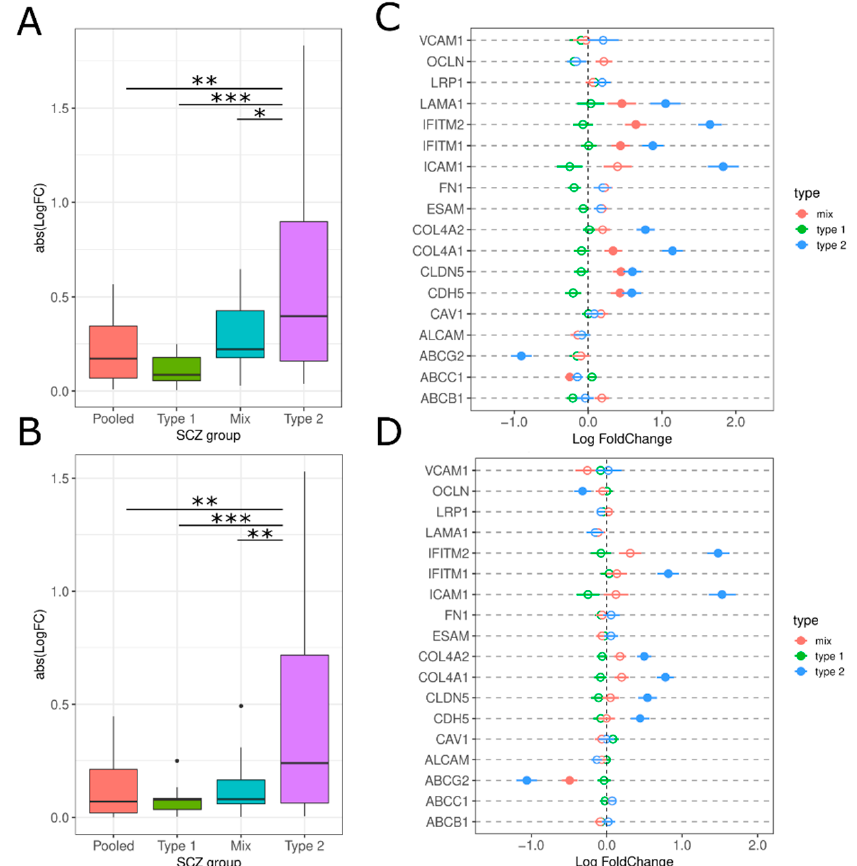
Figure 8. BMEC expression in the SCZ groups. ( A , B ) Absolute LogFC value for BMEC genes for each SCZ group for polyA and riboZ, respectively. * p -value < 0.05, ** p -value < 0.01, *** p -value < 0.001 via Tukey HSD. ( C , D ) LogFC for each BMEC gene across SCZ subtypes for polyA and riboZ, respectively: Type 2 (blue), Mix (red), Type 1 (green). Lines indicate standard error. Filled circles = differentially expressed (Benjamini-Hochberg p -value < 0.05), empty circles = not differentially expressed.